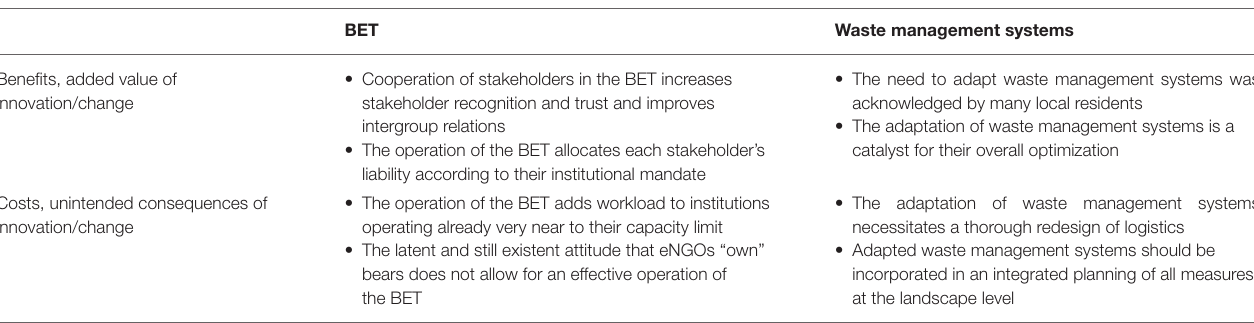
TABLE 2 | Mixed-motive template for bears approaching human